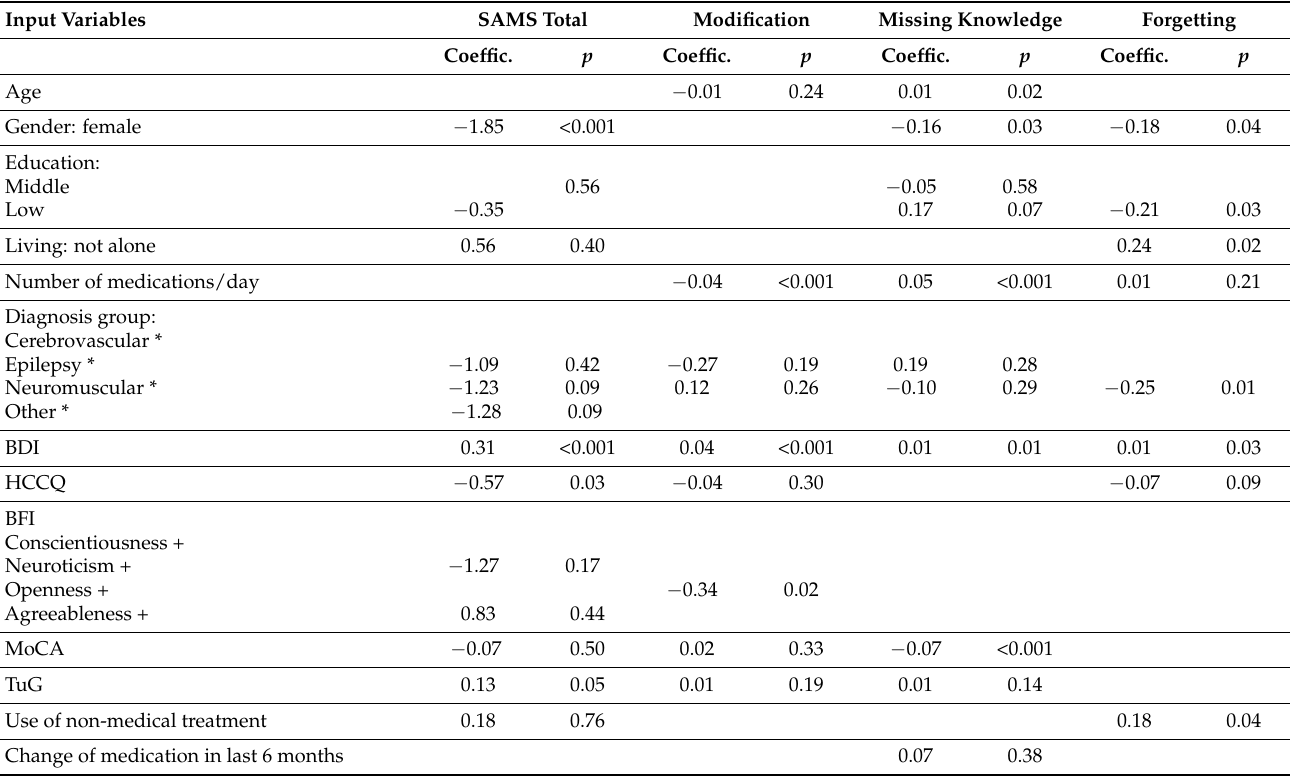
Table 2. Summary of elastic net regularization for SAMS and SAMS factors.